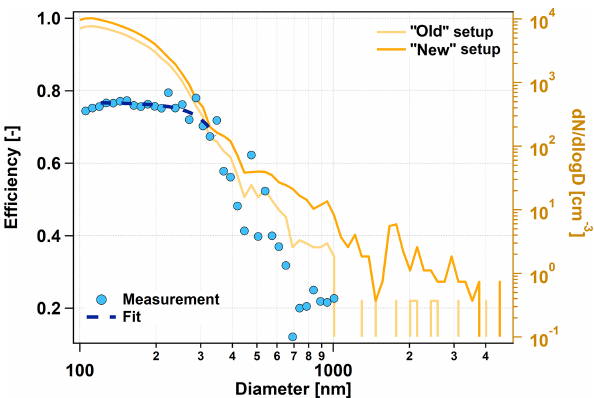
Figure 1. The quantification of the LAS losses in the sampling line. The two orange lines refer to the right axis and show the average room air number size distributions. “Old” setup: time average with the long horizontal tube; “new” setup: time average without the hor- izontal tube. The blue dots show the particle transmission efficiency through the tube, and the dashed dark blue line shows a polynomial fit in the diameter range which was used for the RI